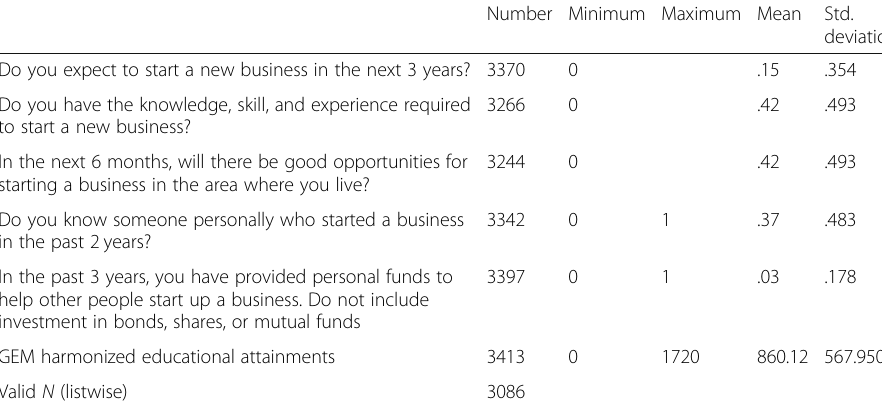
Number Minimum Maximum Mean Std.